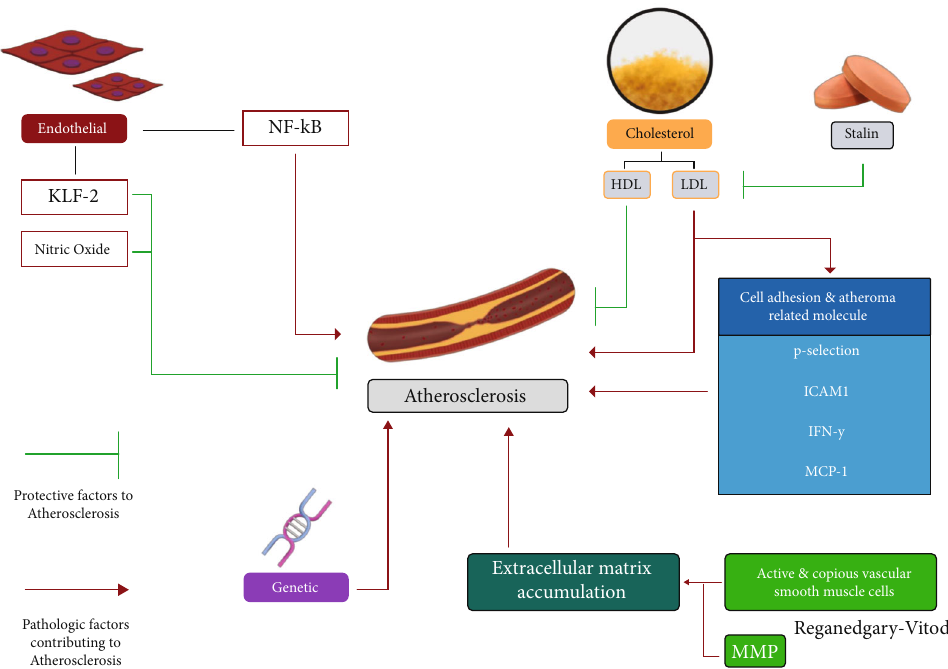
Figure 1: Several factors that a ff ect